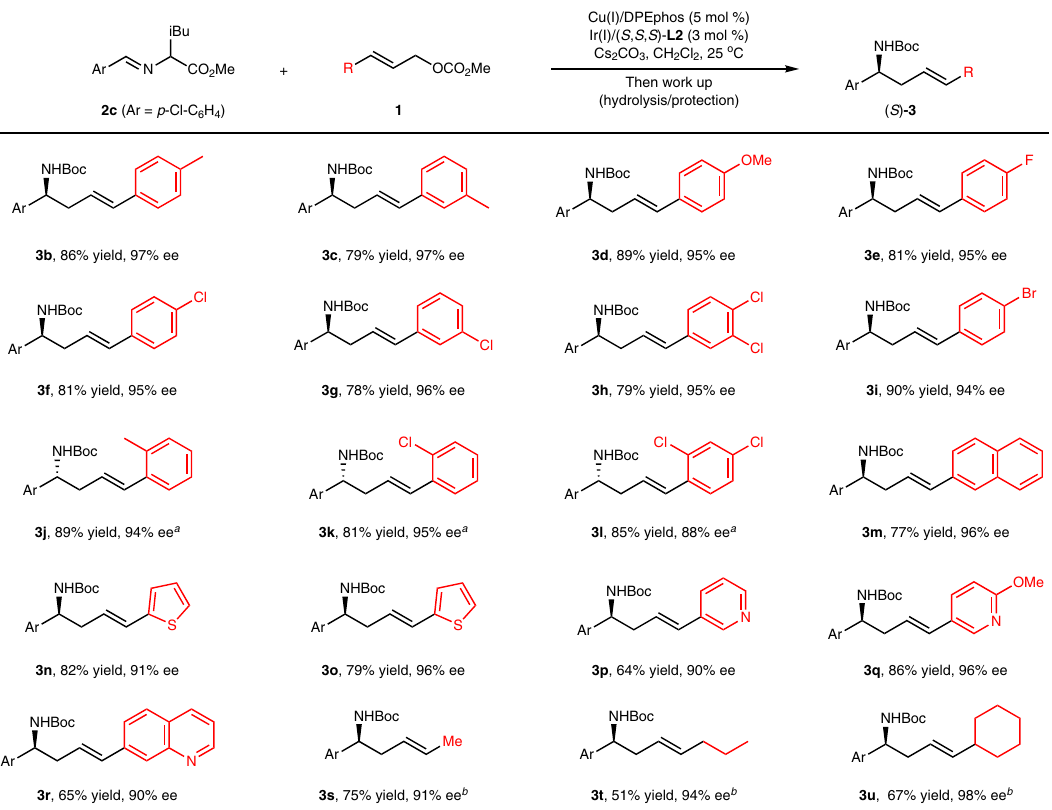
Fig. 5 Substrate Scope of substituted allyl carbonates. Reactions conditions: 1 (0.20 mmol), 2c (0.30 mmol), Cu(I)/DPEphos (0.01 mmol), Ir(I)/( S,S,S )- L2 (0.006 mmol), CH 2 Cl 2 (1 mL), N 2 , 25 o C, 12 – 24 h. Isolated yields were shown. Ee values were determined by HPLC analysis. a [Cu(I)/DPEphos + Ir(I)/( S, S a )- L4 ] complexes were employed as the catalysts. b [Cu(I)/( S,S p )- L1 + Ir(I)/( S,S,S )- L2 ] complexes were employed as the